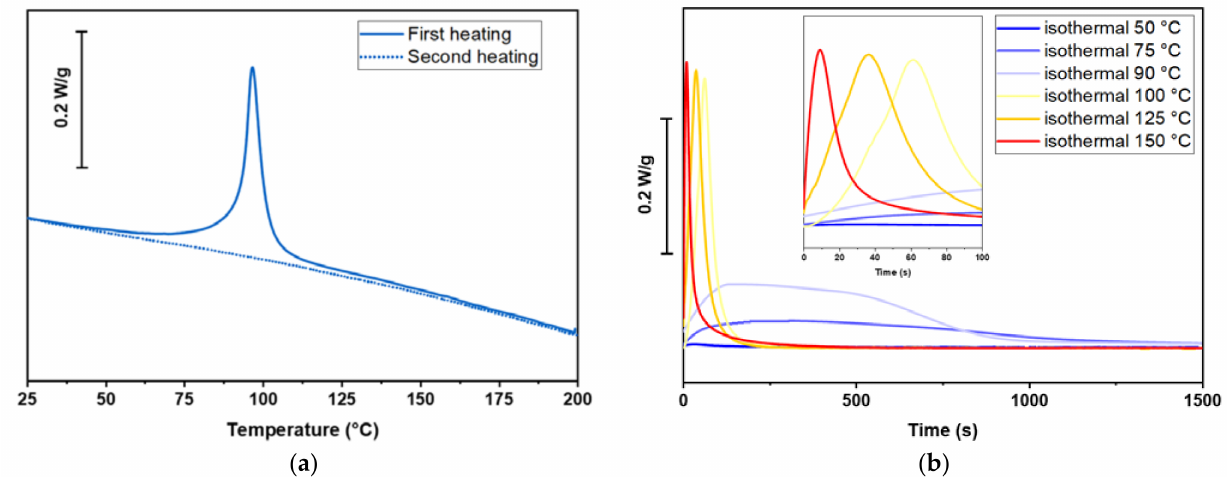
Figure 2. DSC thermogram; ( a ) thermogram curve for the pristine Sylgard, first heating ramp with curing peak at 96 ◦ C (blue continuous curve) and second heating curve (blue dot curve); ( b ) thermogram in isothermal mode for Sylgard at different temperatures.